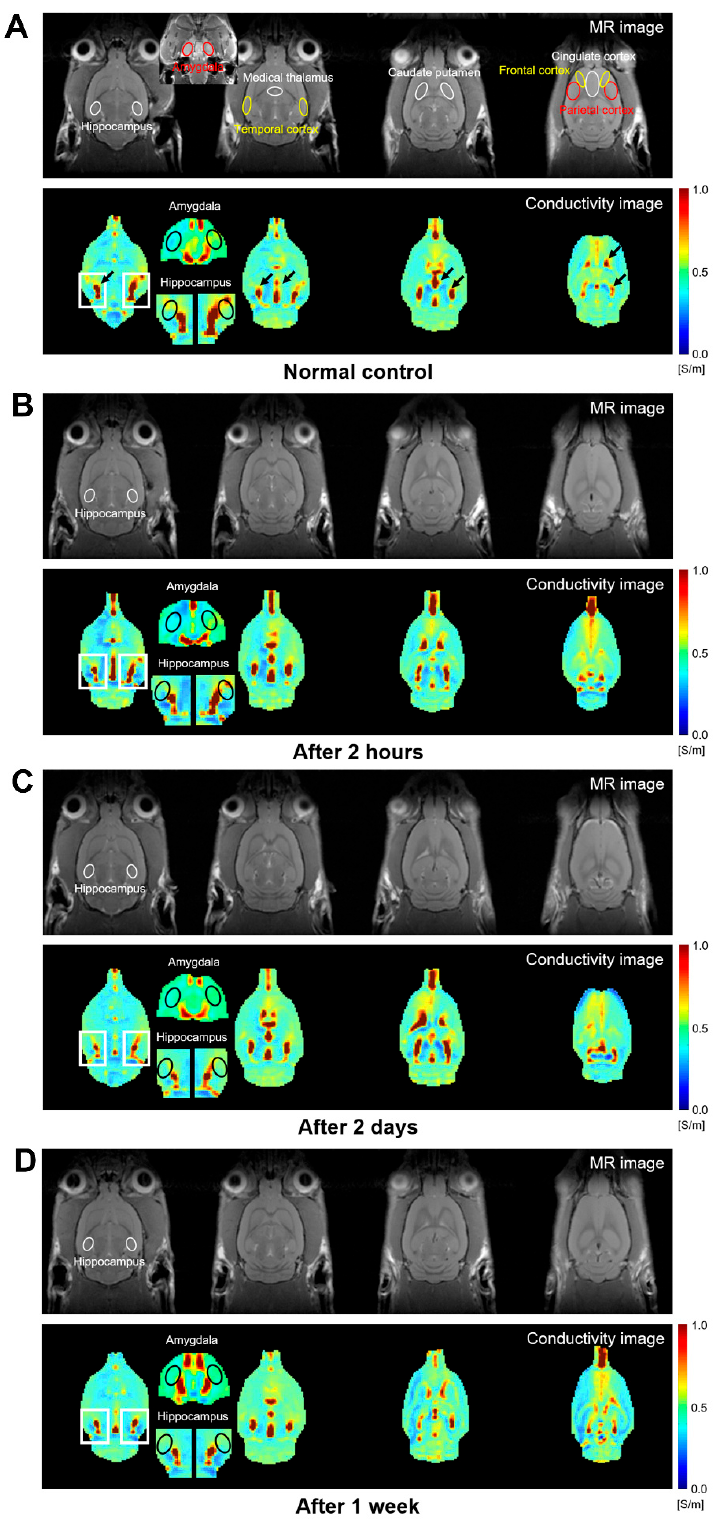
Figure 2. Magnetic resonance (MR) and corresponding conductivity images of rat brains using 9.4 T magnetic resonance imaging (MRI). The imaging results are from four groups representing ( A ) normal control, ( B ) 2 h, ( C ) 2 days, and ( D ) 1 week after the NMDA treatment, respectively. The hippocampal region was enlarged and marked the regions of interest (ROIs) in the conductivity image. The black arrows indicate the highest conductivity in the CSF (cerebrospinal